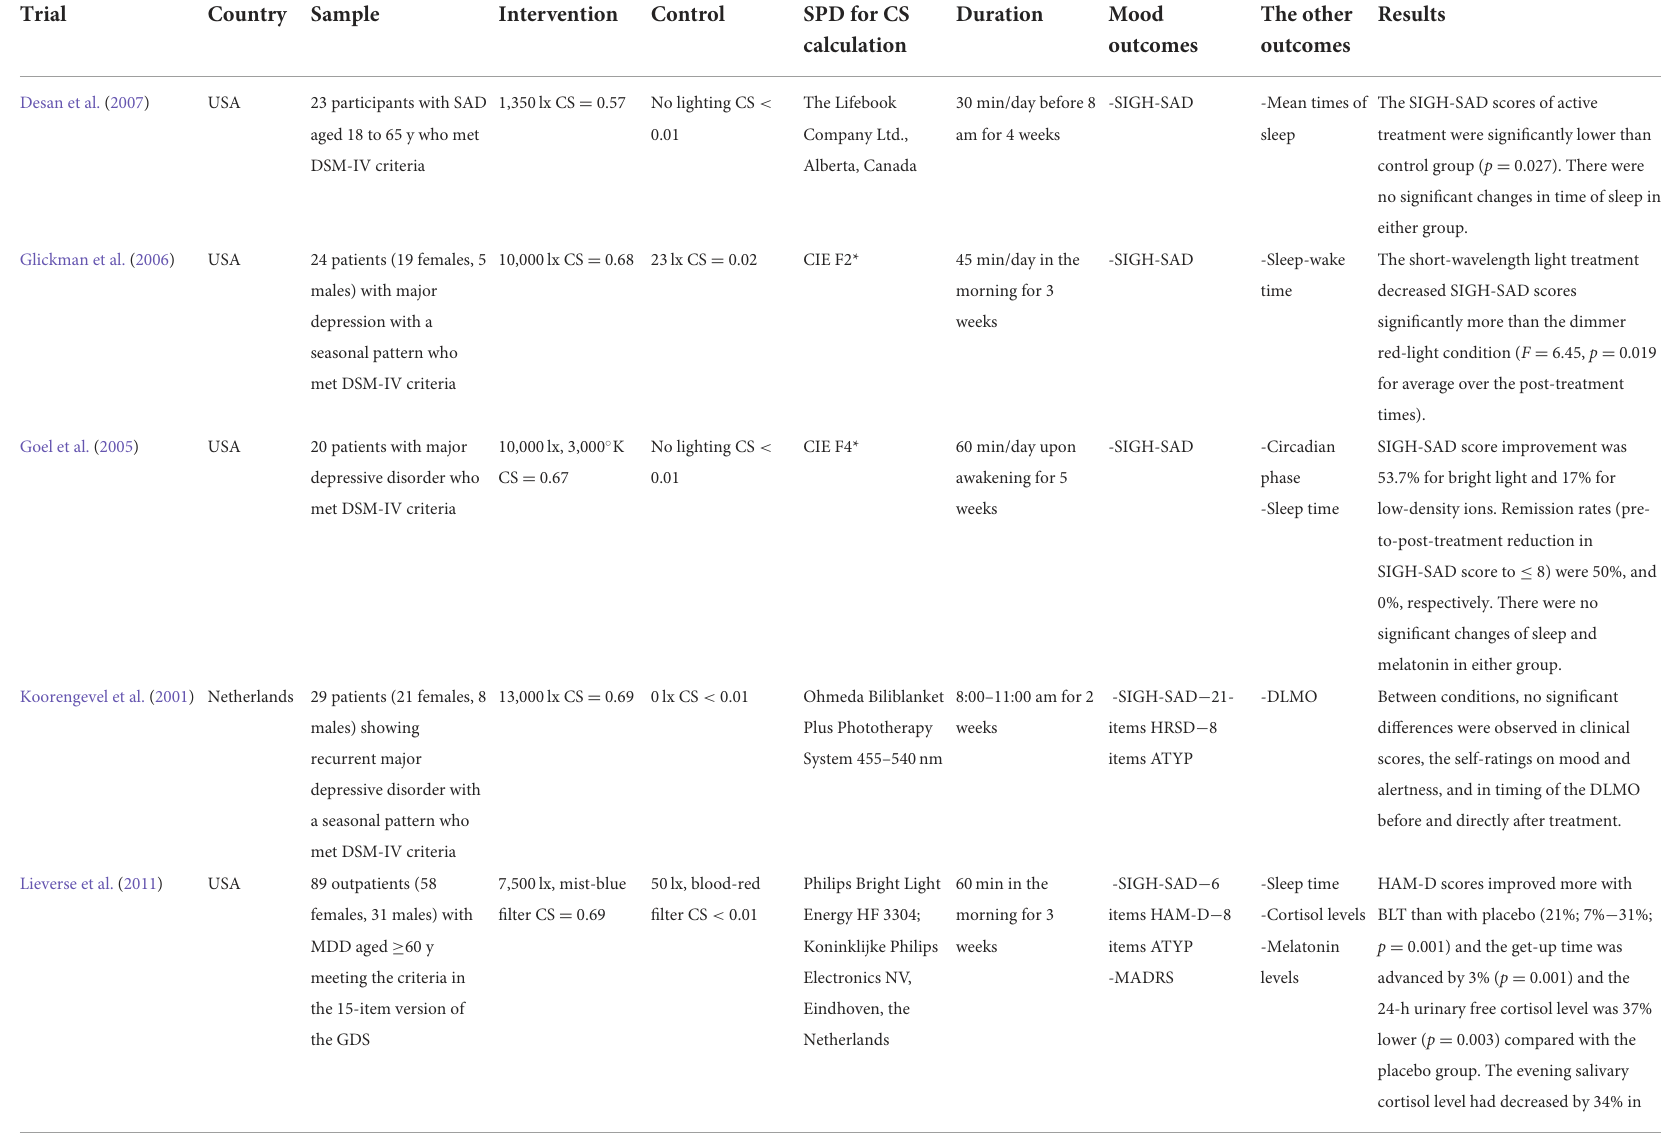
TABLE 1 Characteristics of the included